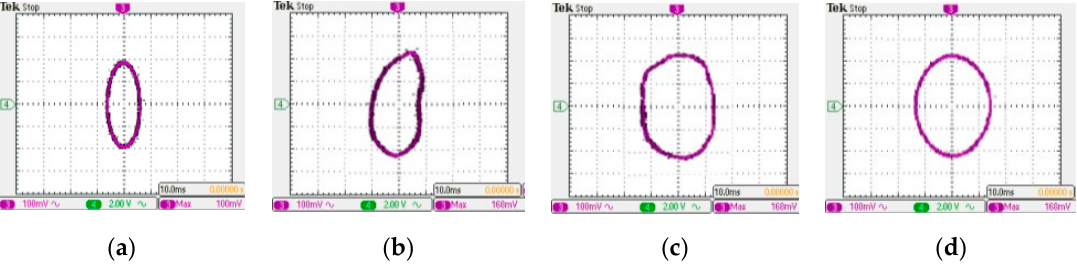
Figure 6. Lissajous figures for measuring resonant frequency: ( a ) 65 Hz; ( b ) 210 Hz; ( c ) 330 Hz; ( d ) 405